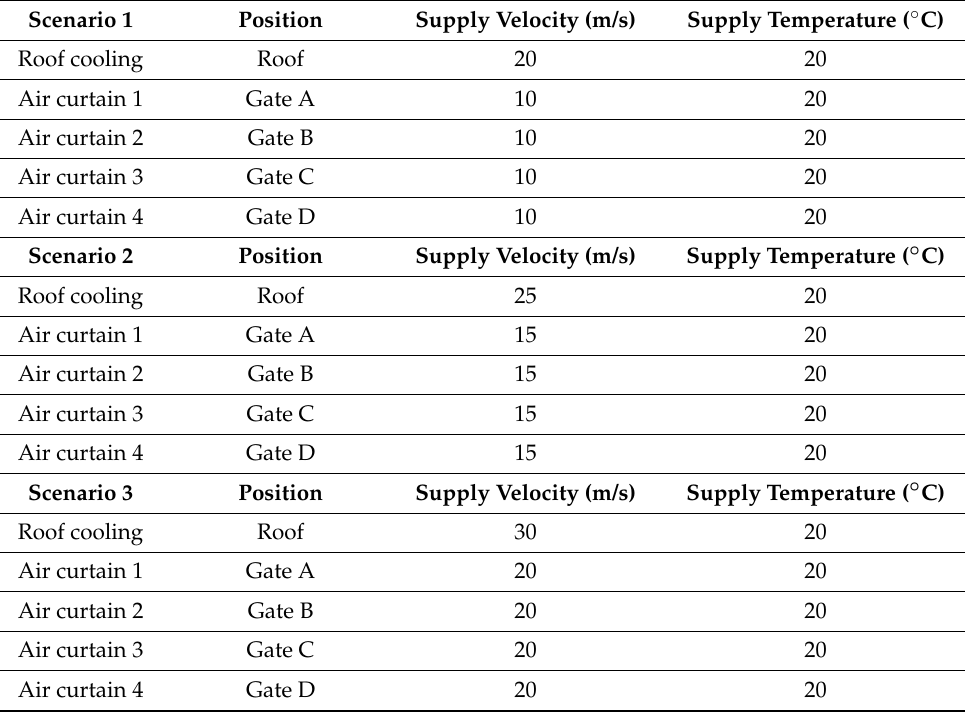
Table 2. Air curtain and roof cooling scenarios proposed in sensitivity